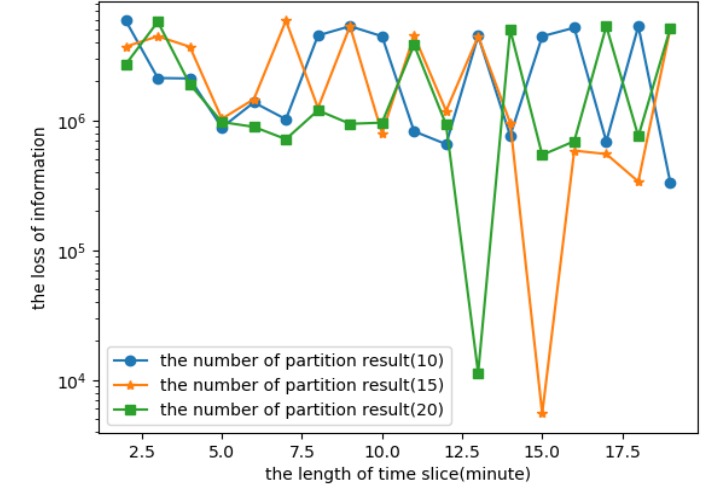
Figure 13. The loss of information (T-drive